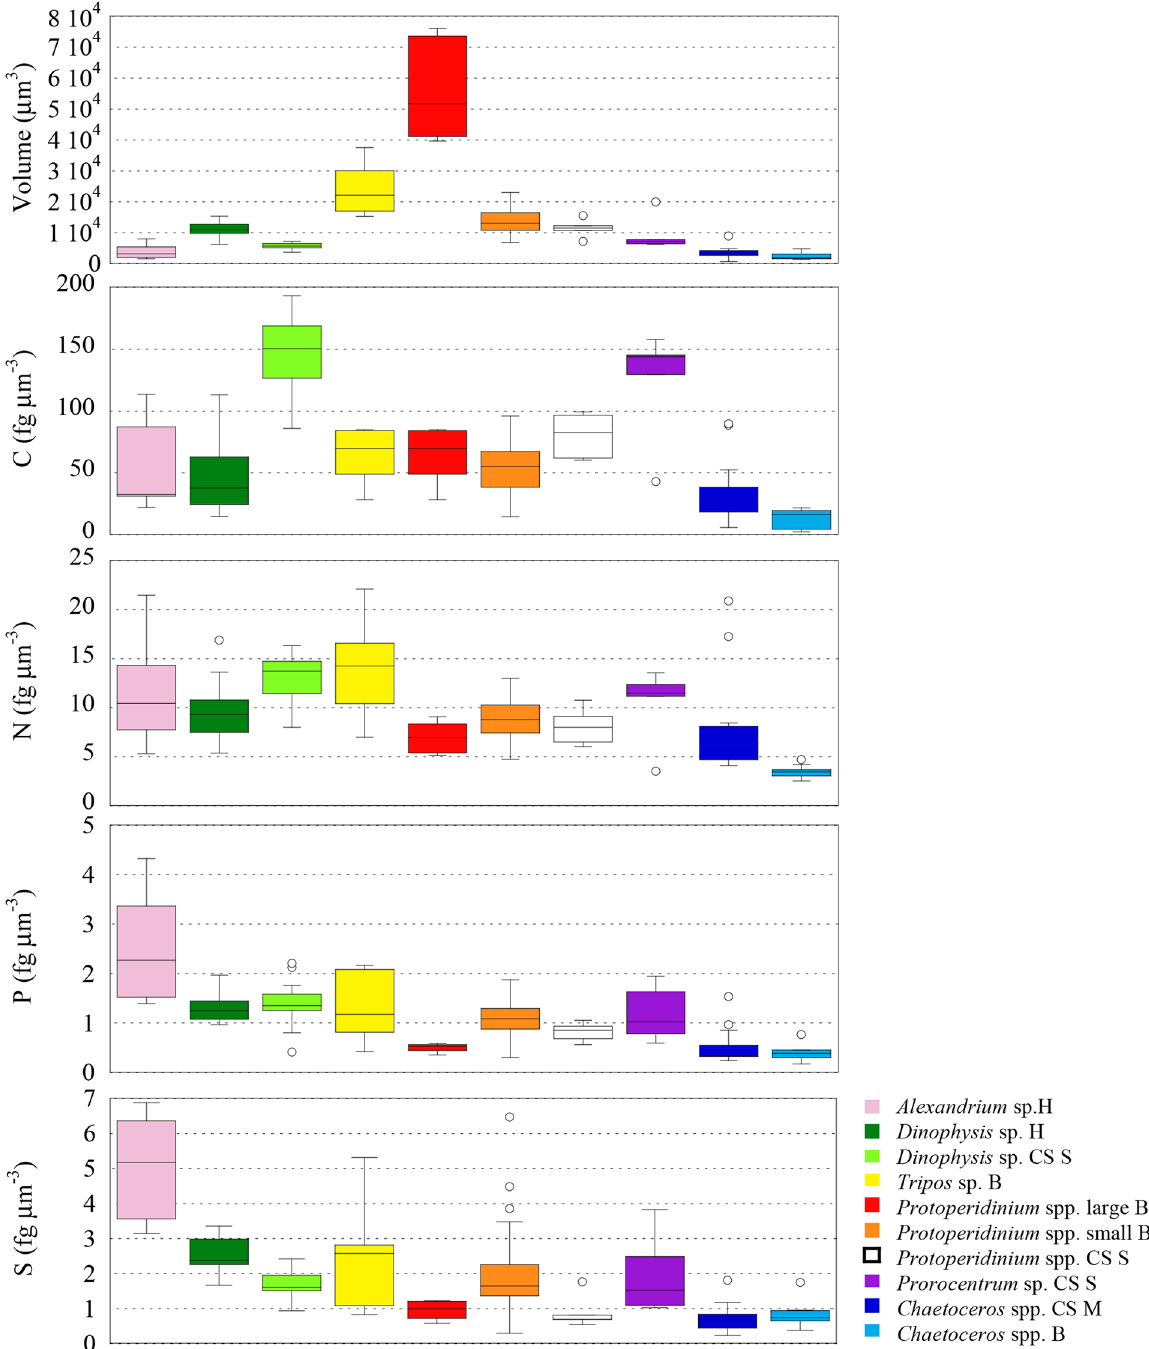
Fig 6. Box plots comparing cell volume (in μ m 3 ) and C, N, P and S elemental concentrations (in fg μ m -3 ) of dinoflagellates and diatoms from the NW Mediterranean Sea. H: Harbour; B: Bay; CS S: Continental Shelf Stratified water column; CS M: Continental Shelf Mixed water